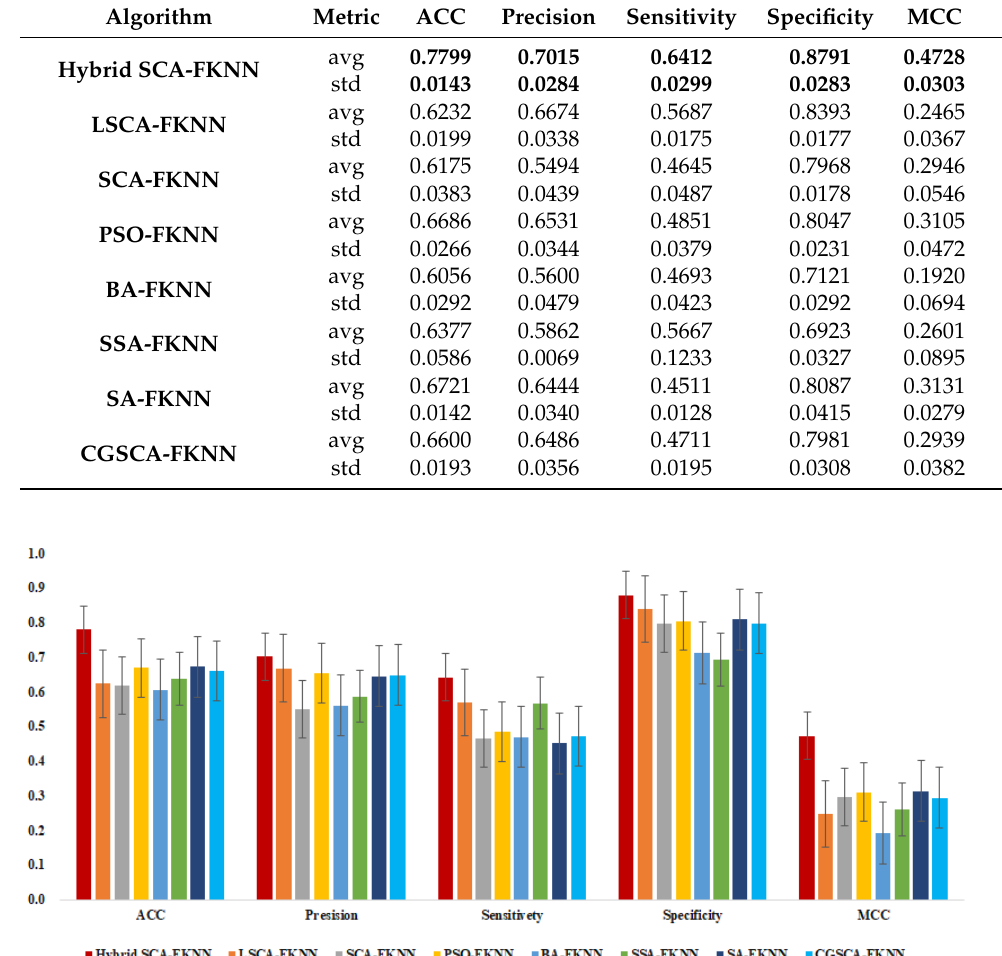
Figure 5. Classification performance of each model on the Bupa